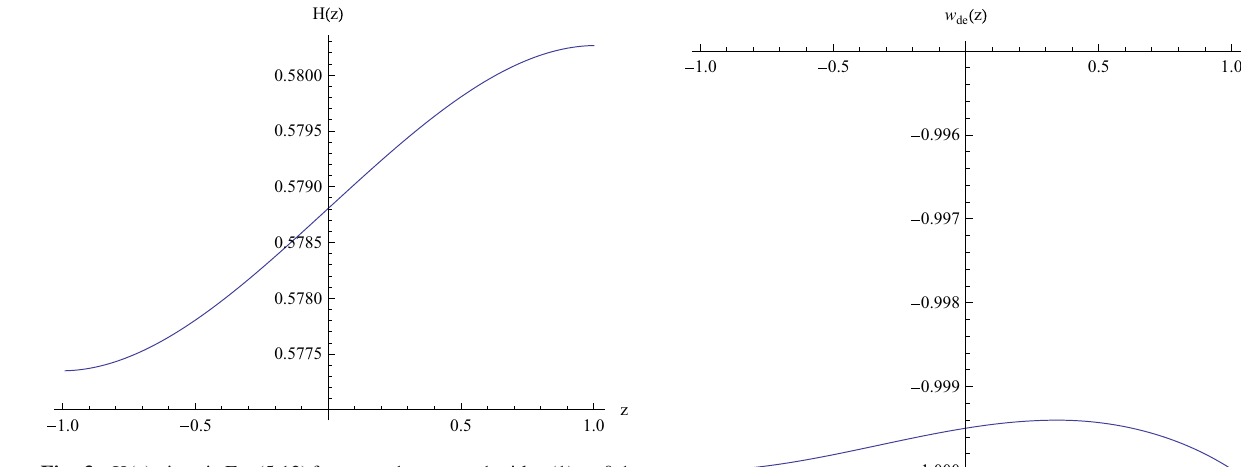
√ 3 ≈ 0 . 577, w ( z ) given in Eq. (5.20) from z = 1 to z = − 1 with 3 de ϕ( 1 ) = 0 . 1, β( 1 ) = 0 . 01, κ = 1, and (cid:24)